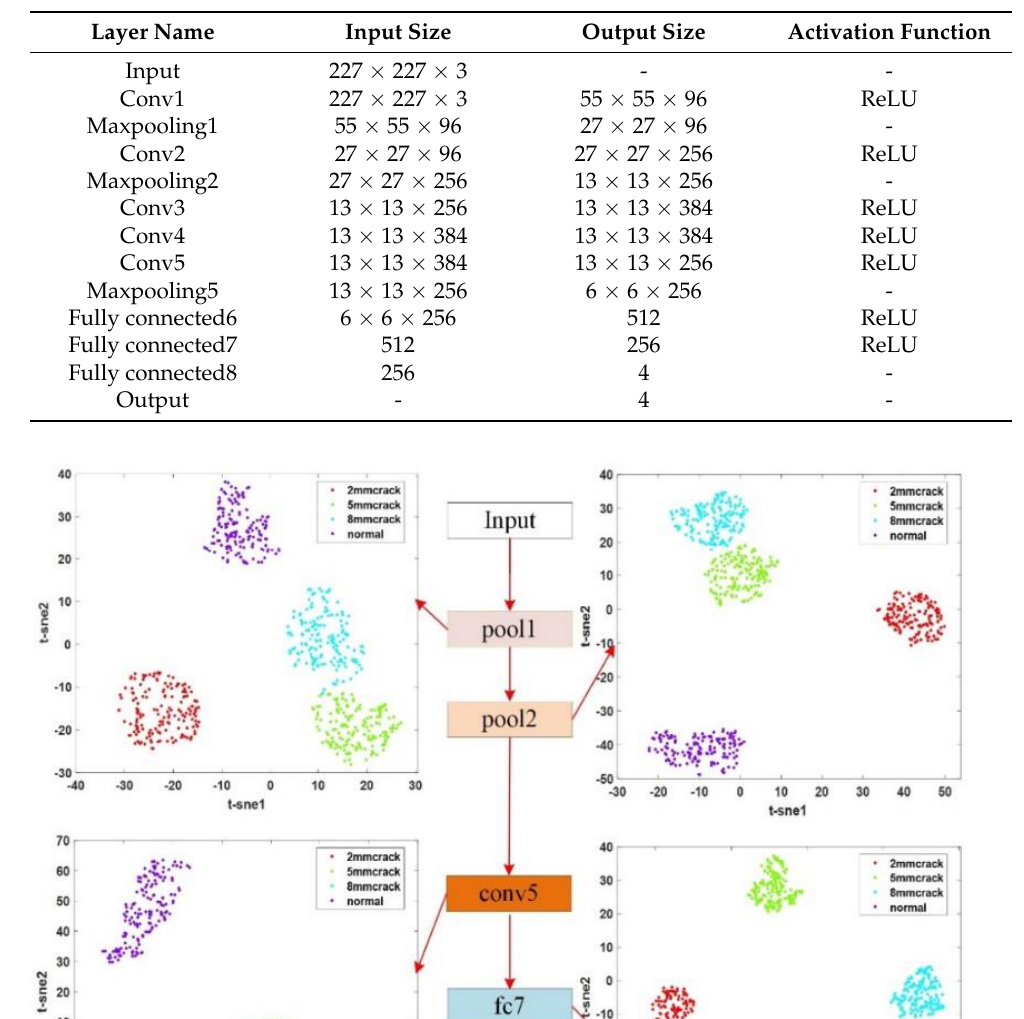
Table 7. SNR and RMSE after using different denoising methods. Labels